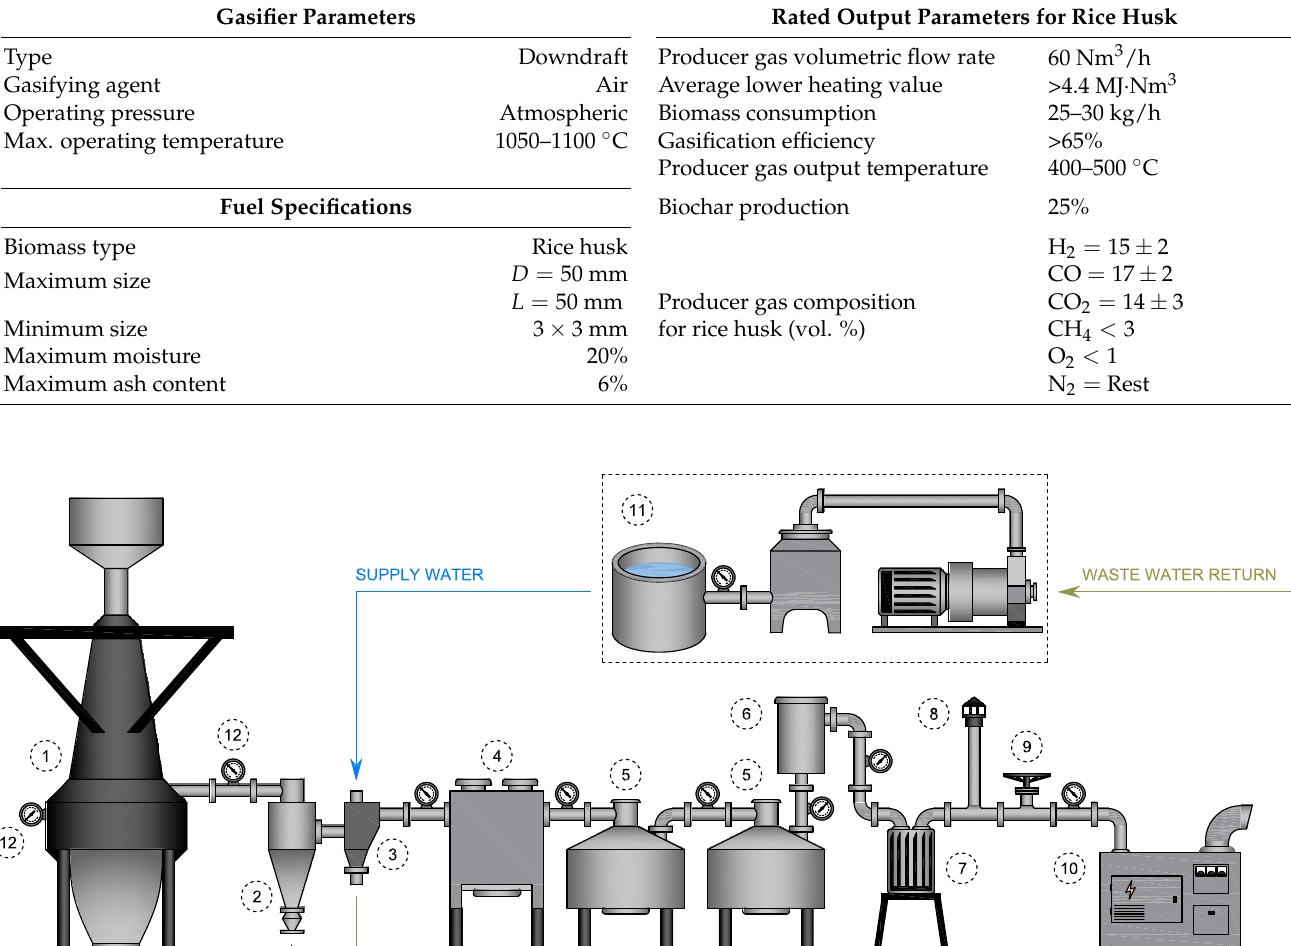
Table 3. Rated operating parameters of the gasification plant.